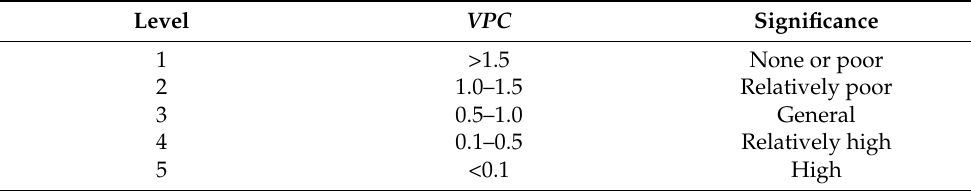
Table 4. Ventilation potential coefficient levels and their